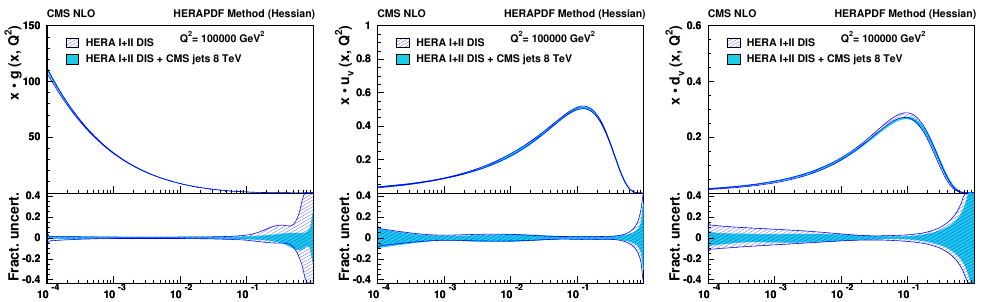
Figure 15 . Same as (cid:12)gure 14, but for the scale of Q 2 = 10 5 GeV 2 .